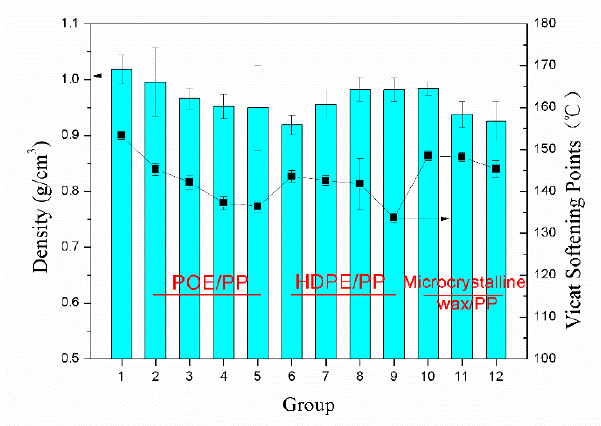
Figure 10. Density and Vicat softening point of the samples with different polymer blends.